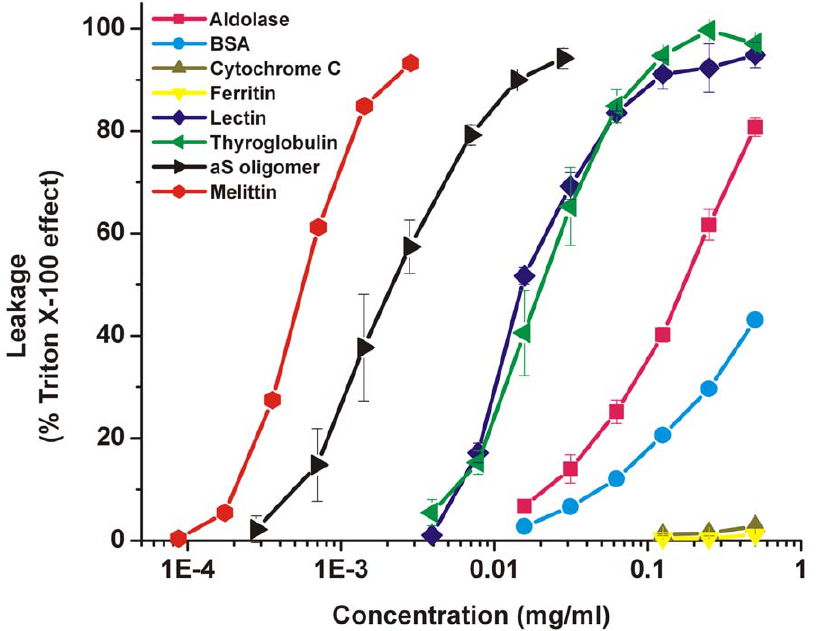
Figure 5. Stability of POPG LUVs. Stability of POPG LUVs to protein absorption was measured by the calcein efflux induced by the addition of different concentrations of several proteins at a phospholipid concentration of 20 m M. The error bars indicate the standard deviation (n=3). doi:10.1371/journal.pone.0014292.g005 time of the LUV-oligomer mixture. The results indicate that the membrane permeability is largest immediately after addition of the a S oligomers. The initial defects seem to heal swiftly and permeability goes down within 5 minutes to a stable level.